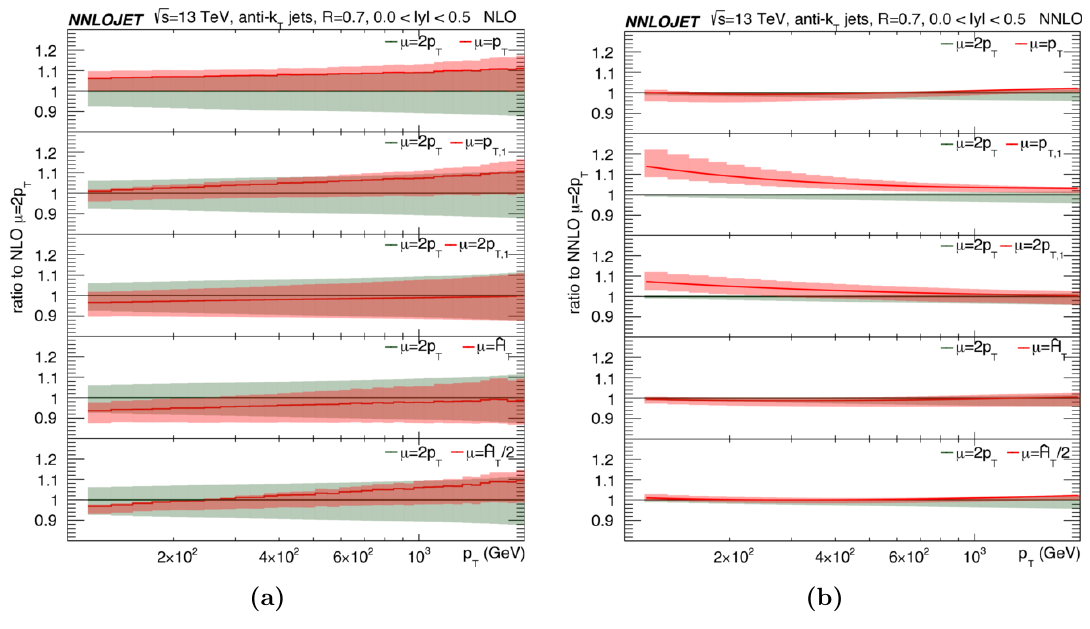
Figure 18 . Ratio of 13 TeV single jet inclusive cross sections to the (cid:22) = 2 p T scale choice at (a) NLO and (b) NNLO with R = 0 : 7 and CMS